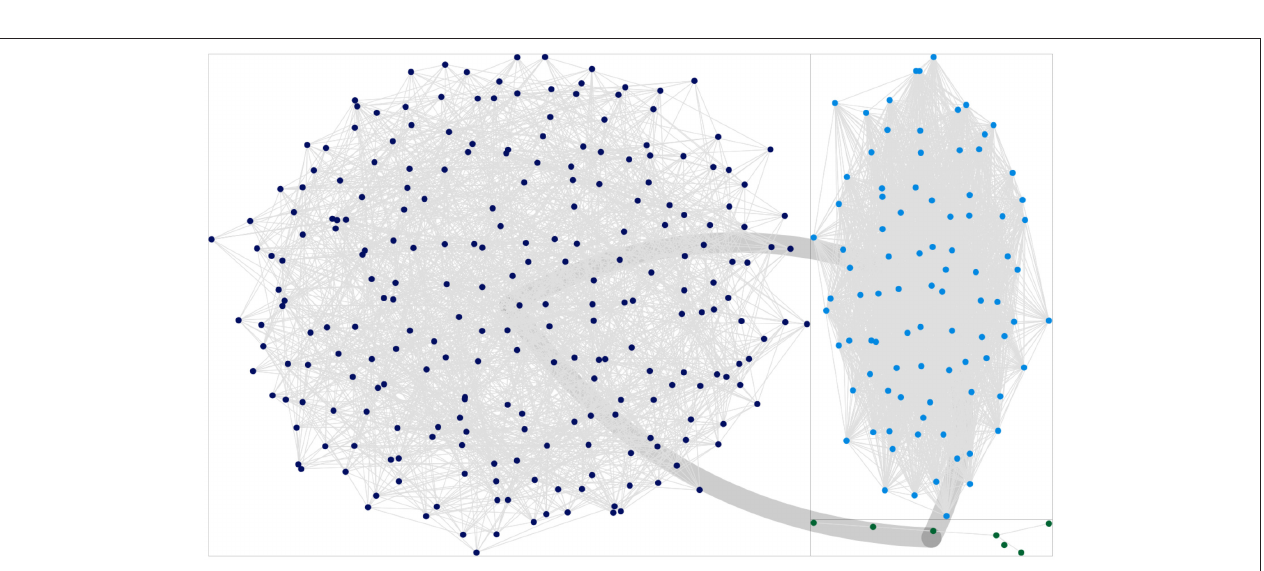
FIGURE 5 | Plot of the clusters obtained via the CNM algorithm, for the network reconstructed using a semi-observational LBP approach, with parameters Q = 5 and t m = 0.35 . It is evident how the bigger community (dark blue dots) is overestimated compared to standard approaches (see also Figure 4 ), at the expense of underestimating minor communities. As stated in the text, this effect can be reduced by lowering t m .